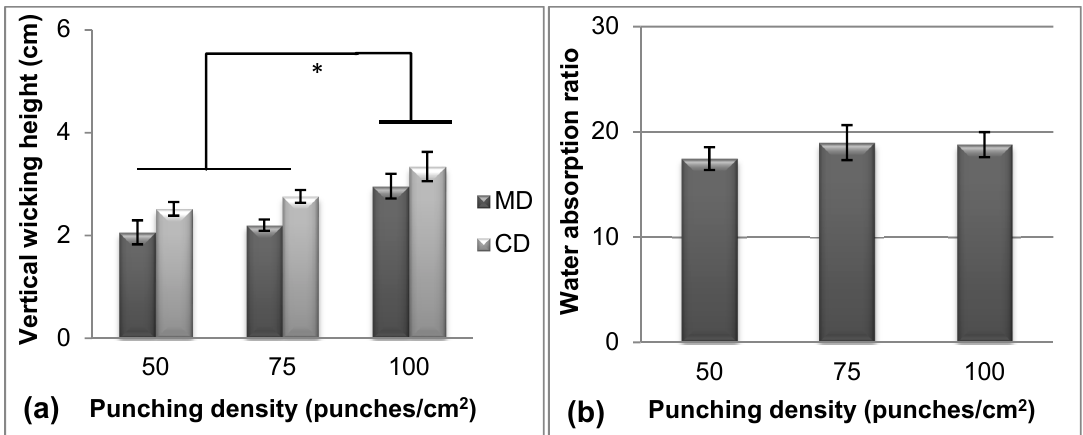
Figure 3. ( a ) Vertical wicking height and ( b ) water absorption of TCP nonwovens with various punching densities. * p < 0.05.